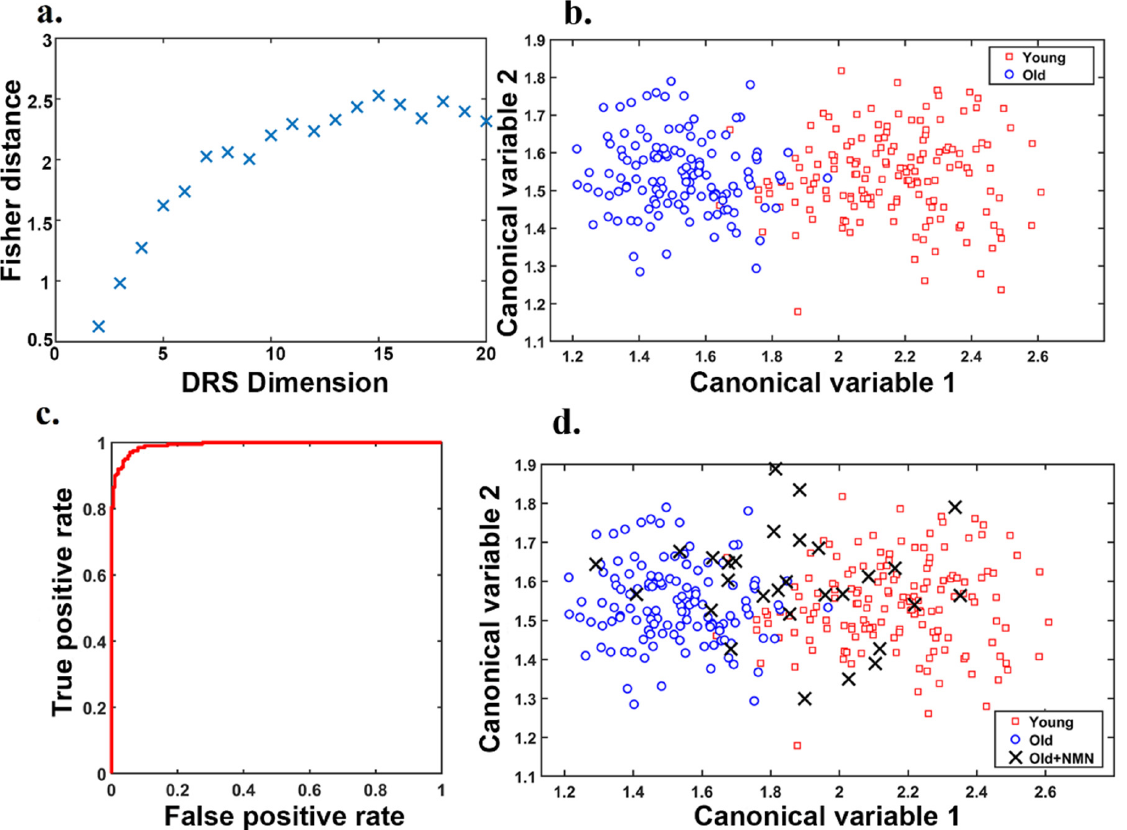
Figure 3. ( a ) Improvement in DRS discriminative power measured by Fisher Distance (FD) with an increasing number of DRS features. ( b ) Discrimination of old and young oocyte morphology using our optimal DRS (points represent oocytes with data augmentation: Number of old data points after augmentation = 126, Number of young data points after augmentation = 156), Figure with no data augmentation is shown in Supplementary Figure S4 ( c ) Classification performance curve of receiver operating characteristics (ROC) for our optimal DRS with 15 features. ( d ) DRS discrimination of oocytes from young and old animals as shown in ( b ) overlaid with oocytes from aged animals treated with the NAD precursor NMN (Number of NMN data points = 29), each data point represents an individual oocyte.